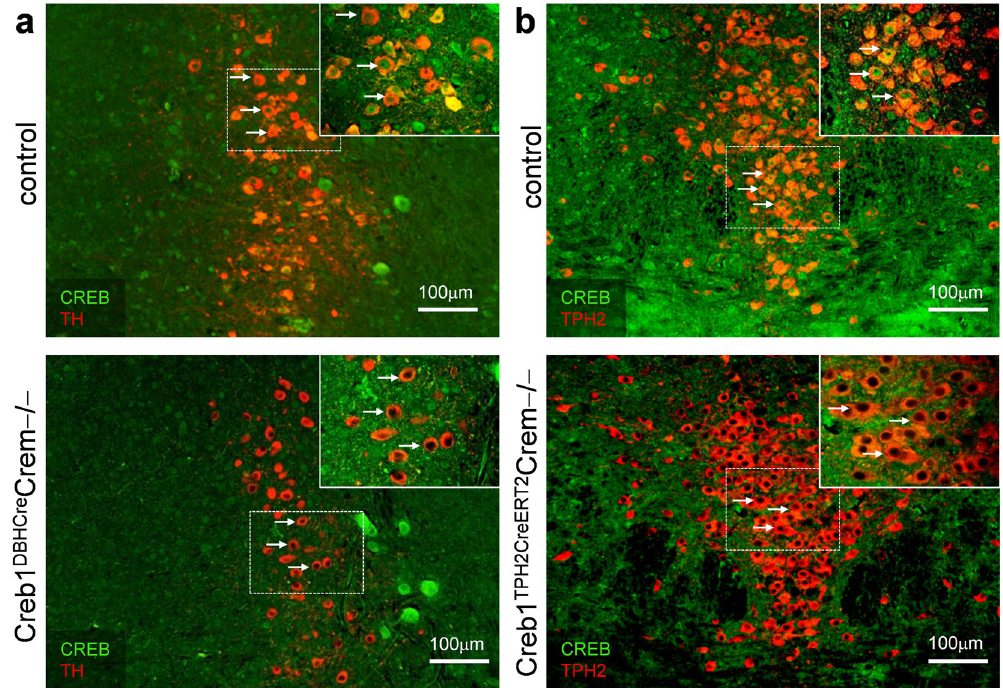
Figure 1. Immunofluorescent staining confirms cell type-specific deletion of CREB in noradrenergic and serotonergic neurons. ( a ) CREB (green) and TH (red) staining in locus coeruleus of control and Creb1 DBHCre / Crem − / − mutant mouse. ( b ) CREB (green) and Tph2 (red) staining in dorsal raphe nucleus of control and